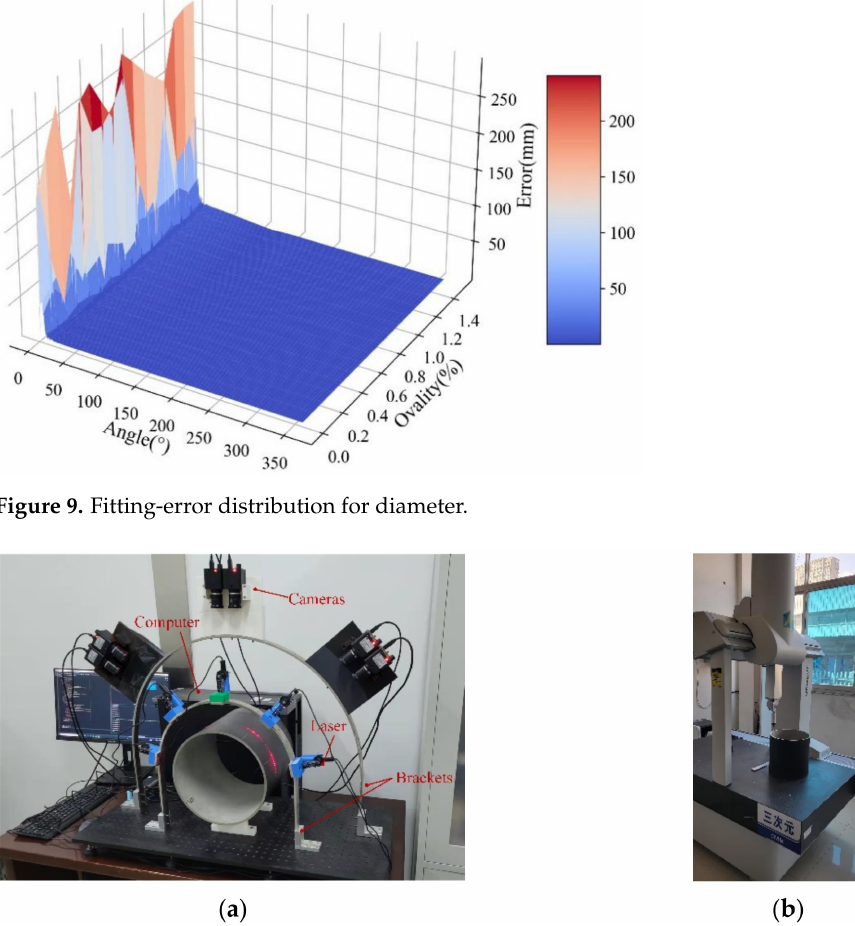
Figure 10. ( a ) The experimental system built in this paper; ( b ) coordinate measuring machine for